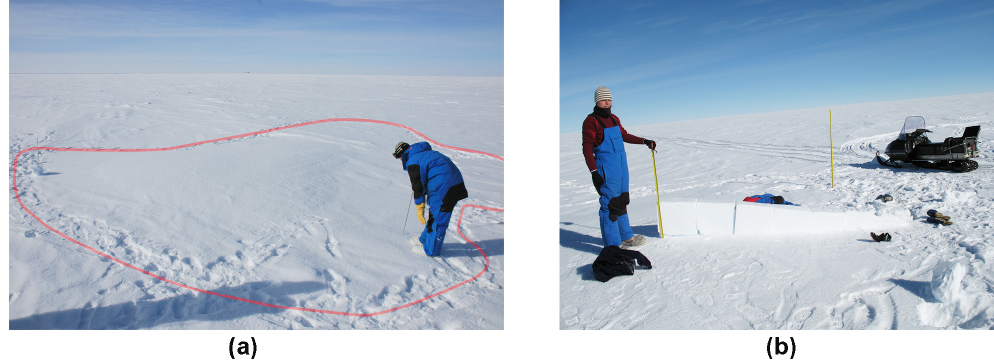
Figure 10. (a) Contour of a “whale back” and (b) longitudinal slice extracted from the same “whale back” in